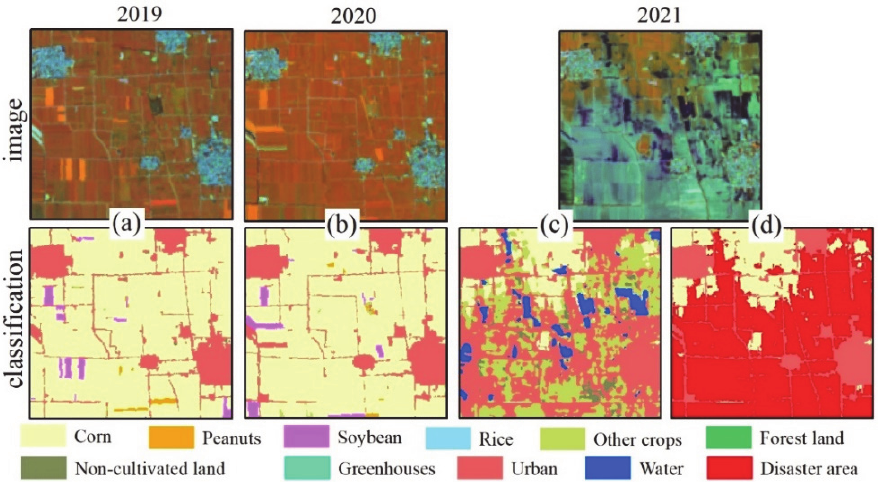
Figure 5. Local segmentation and classification results in different years. ( a ) Classification result in 2019; ( b ) classification result in 2020; ( c , d ) classification and reclassification results in 2021.